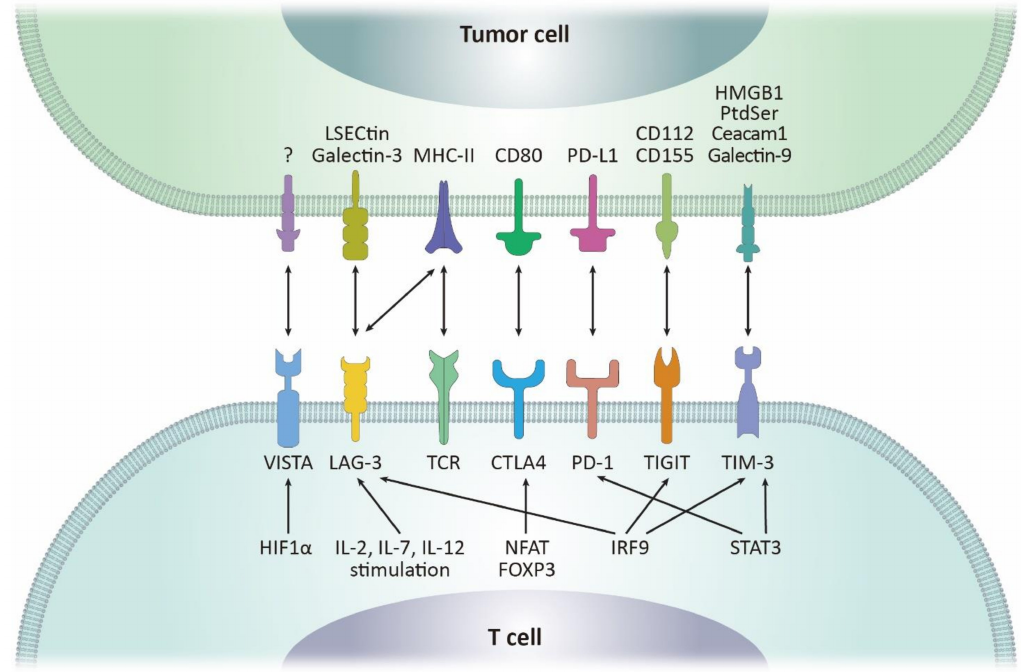
Figure 2. Various types of immune checkpoint receptors and ligands and their regulatory factors. Interactions of immune checkpoint receptors with ligand and their intra- and extracellular regulatory factors are indicated by arrow points. PD-1: programmed death-ligand 1; PD-L1: programmed death-receptor 1; MHC-II: major histocompatibility complex class II; CTLA-4: cytotoxic T lymphocyte antigen 4; VISTA: V-domain Ig suppressor of T cell activation; LAG-3: lymphocyte activation gene-3; TCR: T cell receptor; TIM-3: T cell immunoglobulin and mucin-domain containing-3; IRF9: IFN regulatory factor